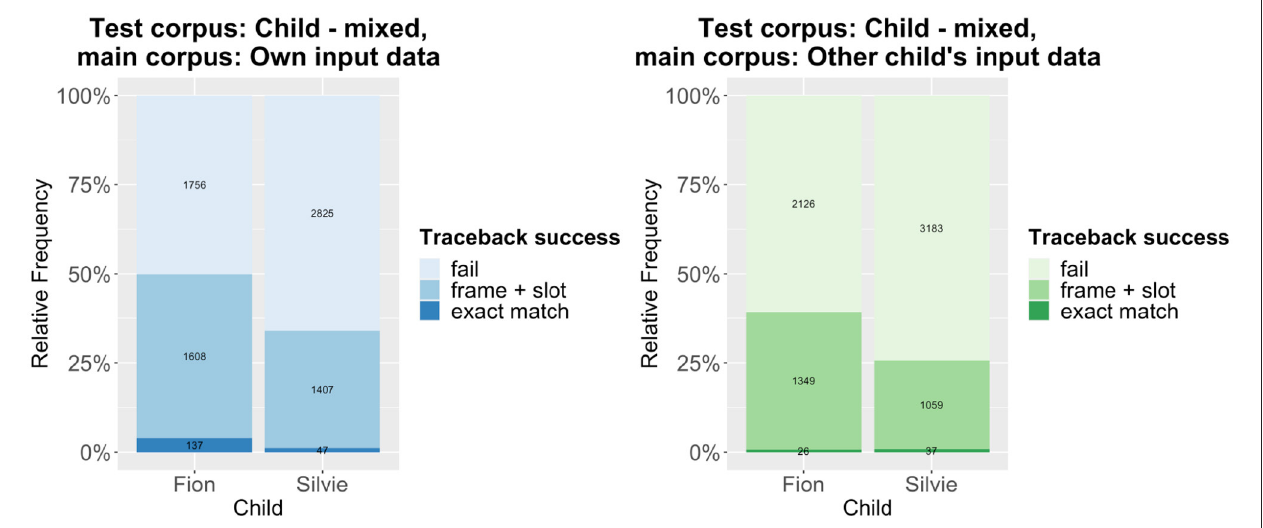
FIGURE 2 | Traceback results–code-mixed data to input